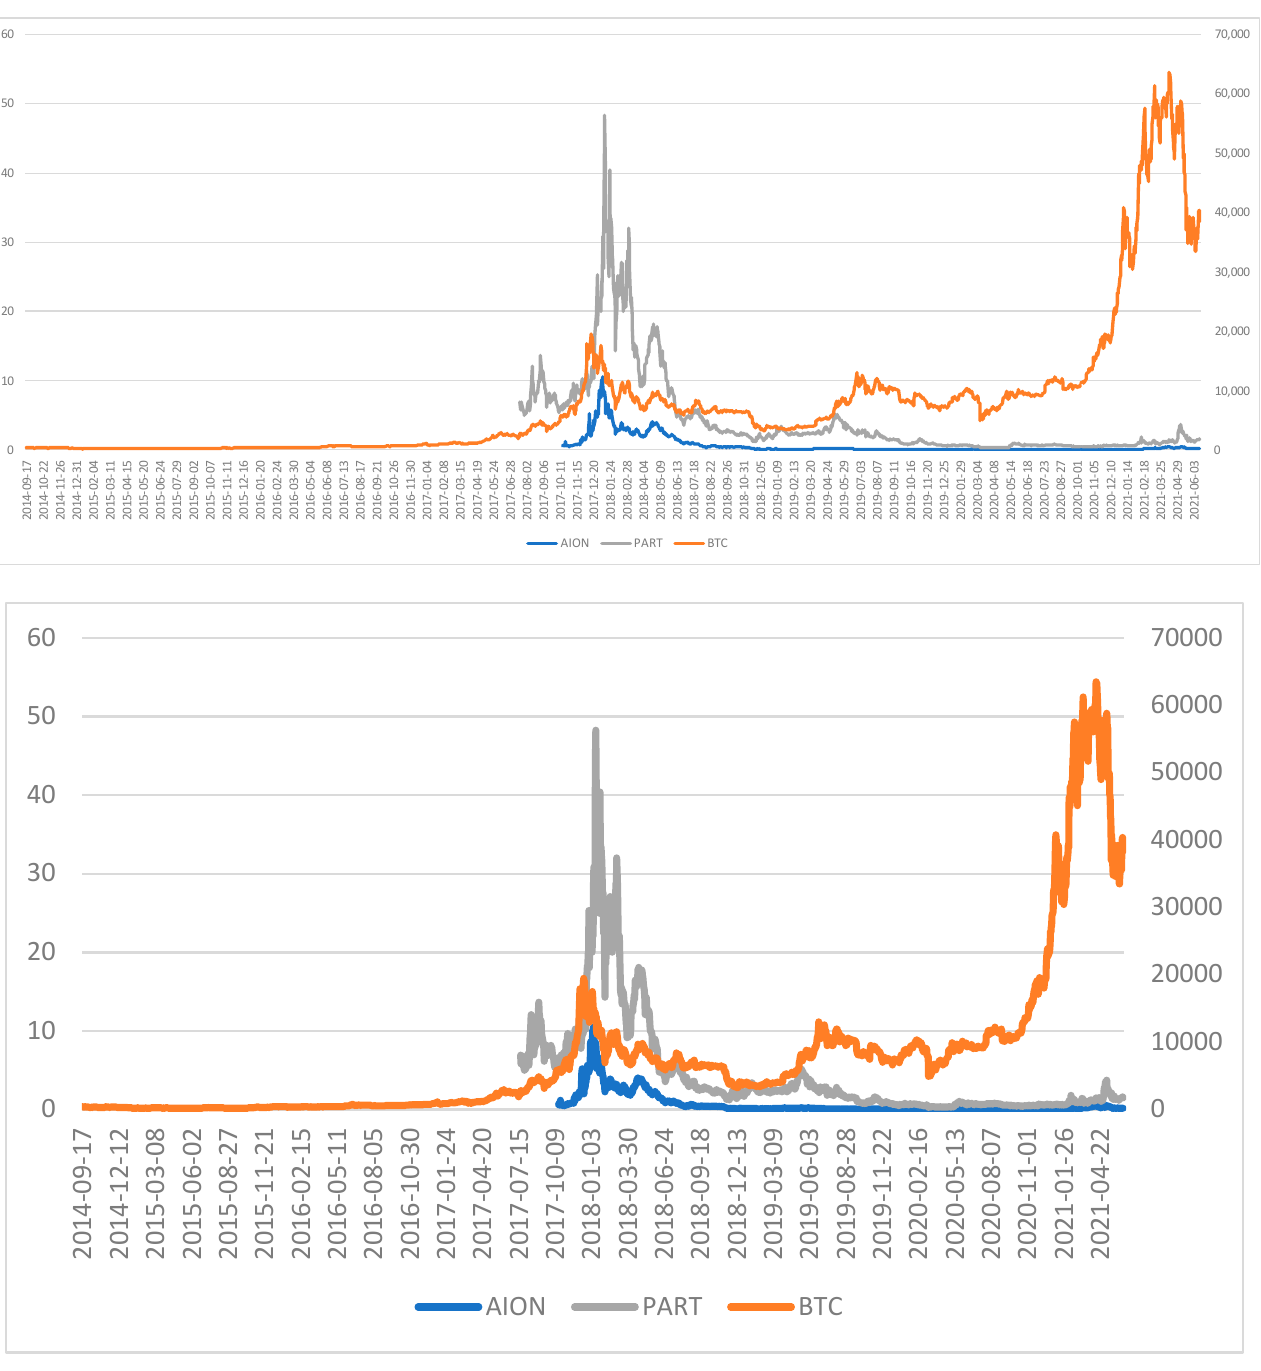
Figure 3. Price development in USD of Bitcoin, BTC (right-side y -axis), Aion, AION and Partcl, PART (two latter in left-side y- axis).